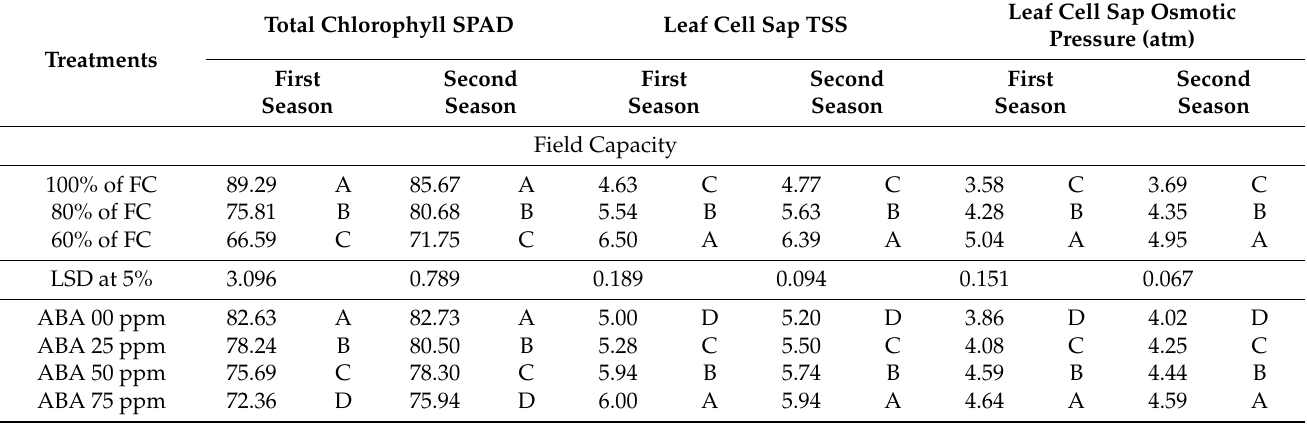
Table 5. Effect of water stress and abscisic acid on total chlorophyll, leaf cell sap TSS, and leaf cell sap osmotic pressure of red cabbage plants (2021–2022